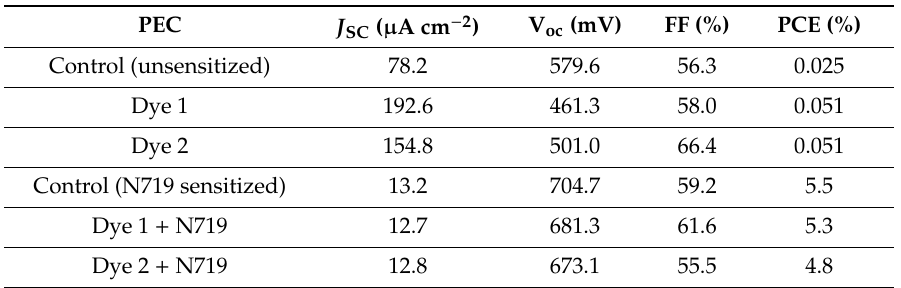
Figure 3. Photocurrent–voltage ( J–V ) characteristics of photoelectrochemical cells (PECs) sensitized only with ( a ) dye 1 and 2 including a control (unsensitized) together with ( b ) N719 co-sensitized. The control PEC in ( b ) was sensitized only with a dye N719. Table 2. Summary of photovoltaic parameters for di ff erent PECs sensitized with bodipy dye 1 or 2 and co-sensitized with dye 1 + N719 or dye 2 + N719 including the corresponding control (unsensitized and N719 sensitized) PECs.